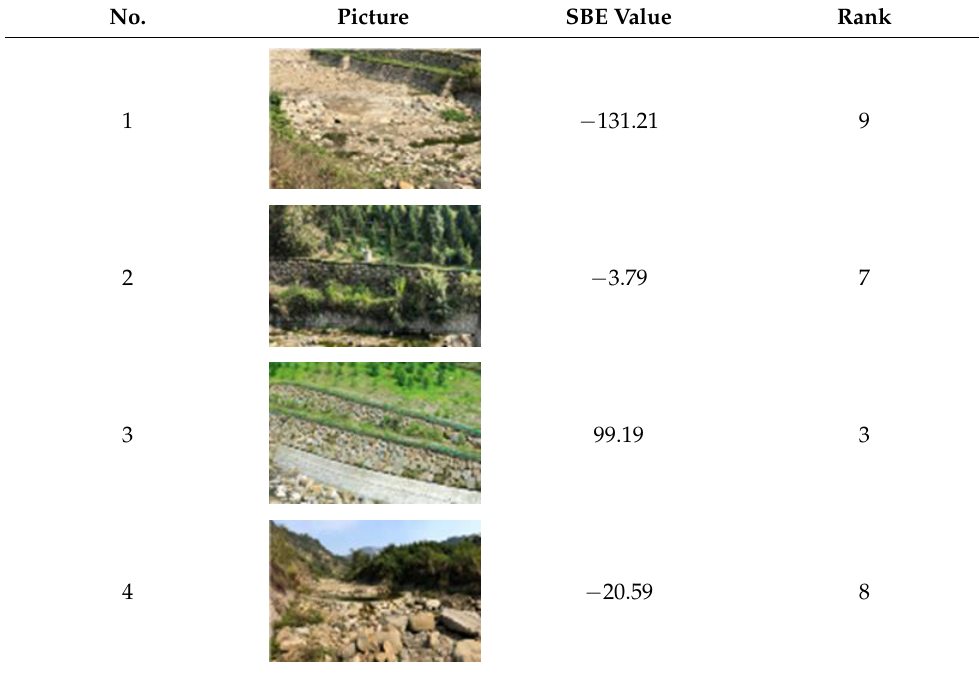
Table 8. SBE results of the “Upstream Renovation Project of Toubiankeng Stream in Zhongpu.”.